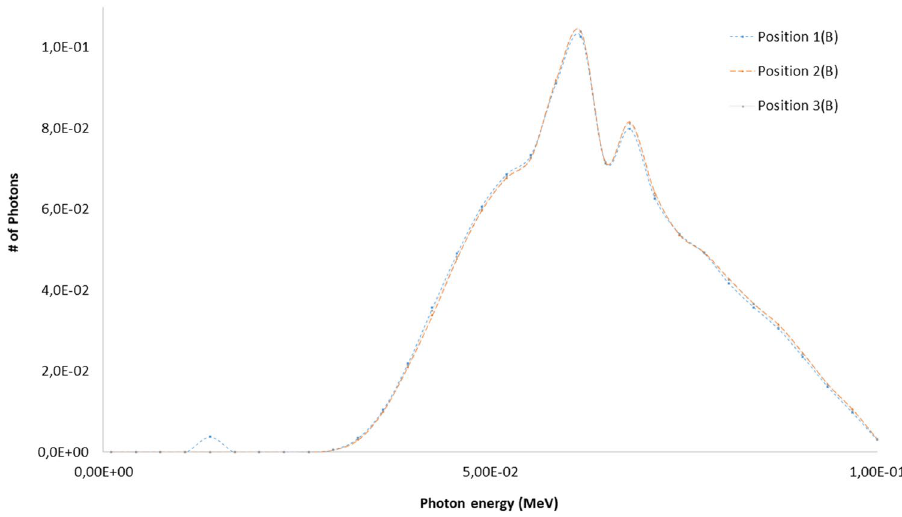
Figure 8. Scenario B. Photon spectra evaluation at the three MCNP detectors (see Fig. 2 and Table 5 for details). Photon energy scale in MeV.